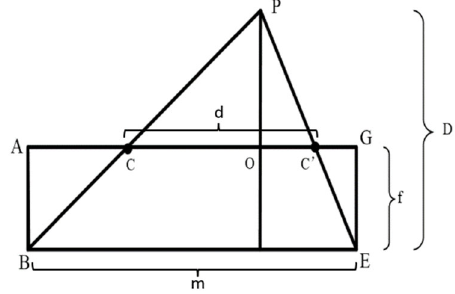
Figure 6. Parallax distance schematic.